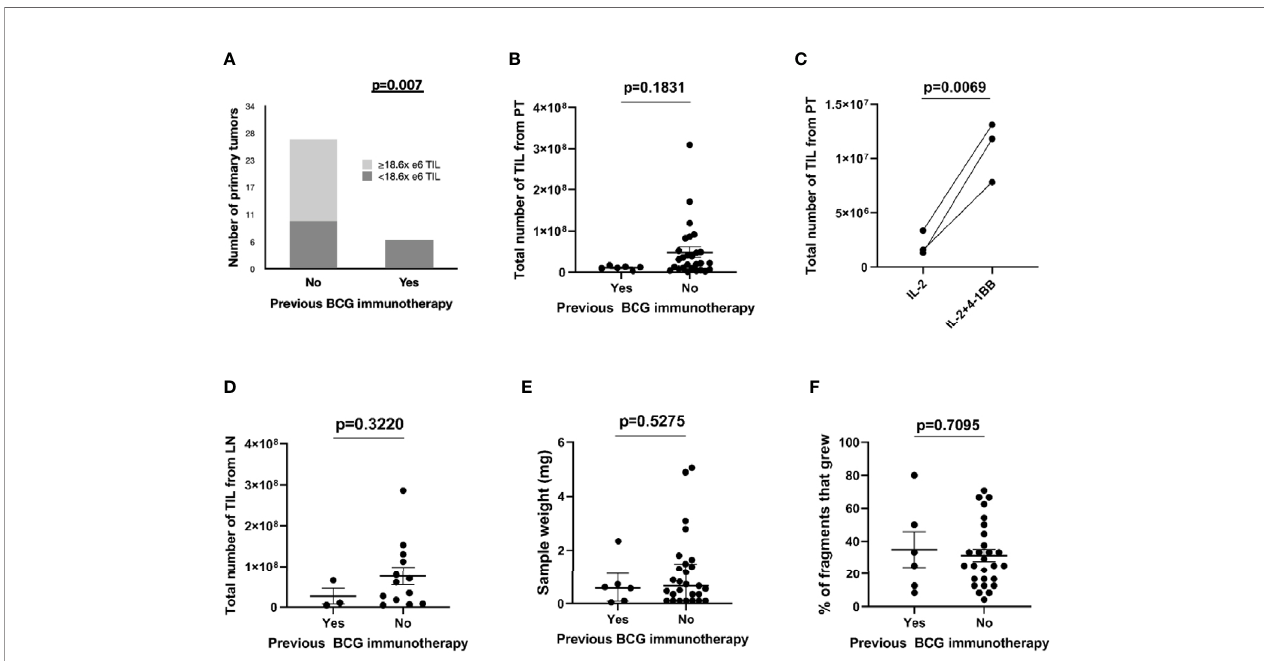
FIGURE 2 | Expansion of TIL from bladder tumors strati fi ed by BCG immunotherapy. The total number of TIL expanded from bladder or LN tumor fragments was measured at 4 weeks after initiation of culture. (A) TIL growth from primary tumors strati fi ed by previous BCG immunotherapy and median number of expanded TIL in 33 patients. Fisher ’ s exact test. (B) Total number of expanded TIL from BCG-naïve primary tumors (27 patients) and from primary tumors with previous exposure to BCG immunotherapy (six patients). Each point represents the total TIL per patient (the sum of all TIL that was generated from each fragment within an individual patient). Median and interquartile range. Mann-Whitney test. (C) Total numbers of expanded TIL from three primary tumors previously treated with BCG immunotherapy. Fragments of the surgical specimens were cultured either in IL-2 (6000 IU/ml) only or in IL-2 (6000 IU/ml) + 4-1BB (10 ug/ml). Wilcoxon-signed rank test. (D) Total number of expanded TIL from BCG-naïve lymph nodes (13 patients) and from lymph nodes with previous exposure to BCG immunotherapy (three patients). Each point represents the total TIL per patient (the sum of all TIL that was generated from each fragment within an individual patient). Median and interquartile range. Mann-Whitney test. (E) The sample weight (mg) of primary tumors sent to the lab for expansion of TIL (six BCG-treated samples and 27 BCG- naive samples). Median and interquartile range. Mann – Whitney test. (F) The percentage of fragments that grew TIL from the total number of fragments plated (six samples from BCG-treated primary tumors and 27 samples from BCG-naive primary tumors). Median and interquartile range. Mann – Whitney